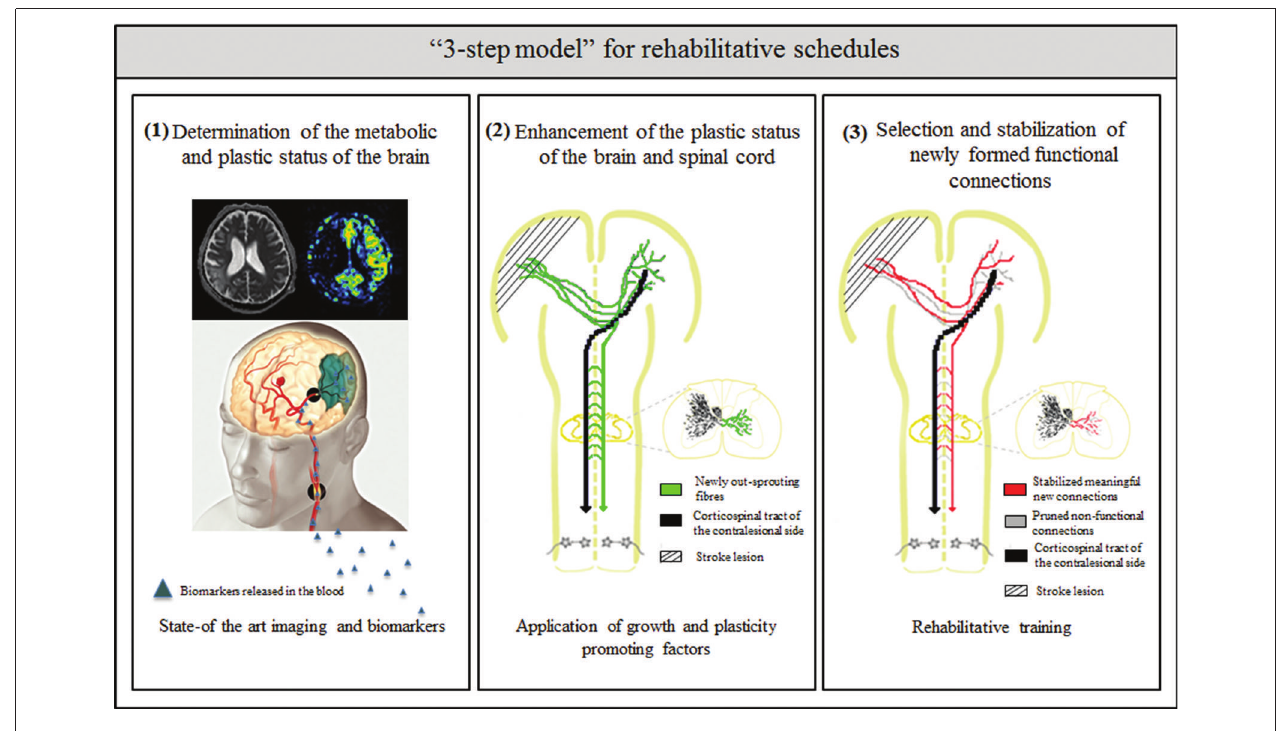
repair and plasticity mechanisms in the ispi- and contralesional hemisphere as well as the spinal cord by application of growth and plasticity-promoting factors such as anti-Nogo-A antibody or Chondroitinase ABC; and (3) selection and stabilization of newly formed functional connections and pruning of non-functional ones by rehabilitative